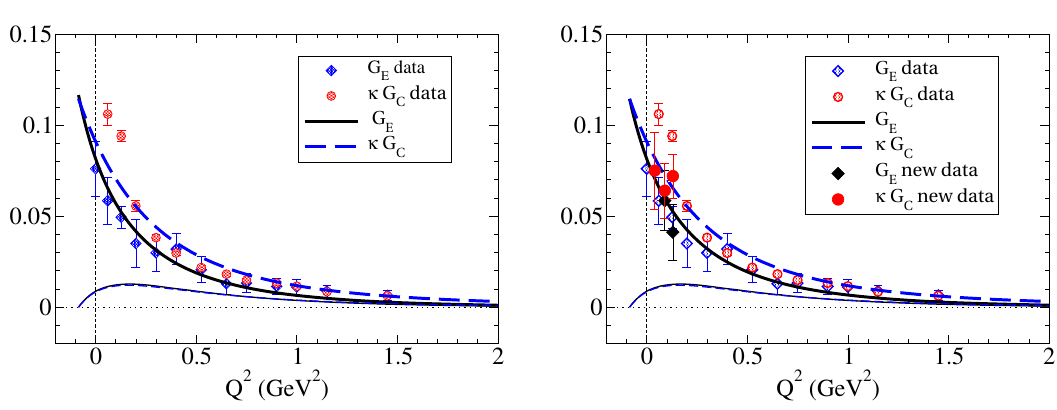
for convenience. The 2 M Δ